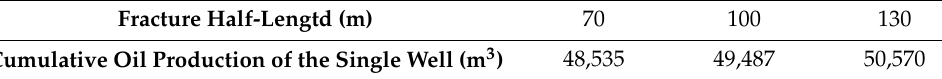
Table 13. Calculation results of di ff erent fracture half-lengths.